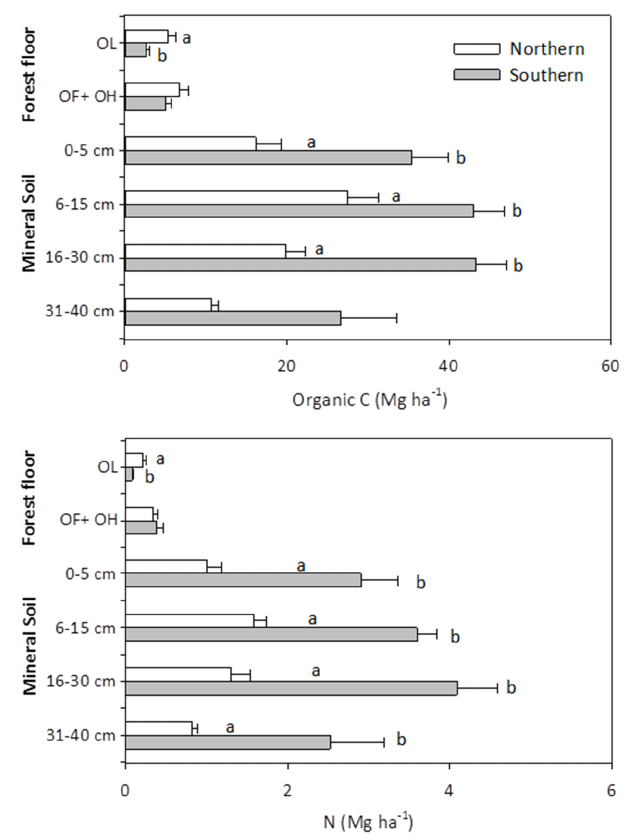
Figure 3. C and N pools in the continuum forest floor ‐ mineral soil of a northern and a southern beech forest. Values are means ± standard error; n = 36 (6 sampling plots, 2 sampling seasons, 3 replicate analyses). Different lower ‐ case letters indicate significant differences between sites ( t ‐ test; overall significance level = 0.05). Forests 2016 , 7 , 181